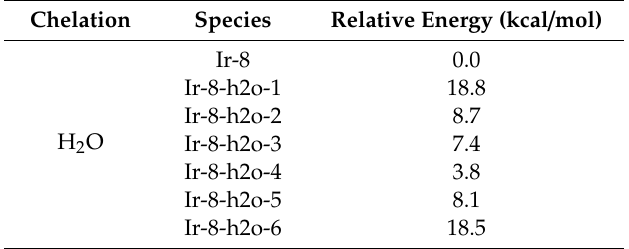
Table 3. The e ff ect of H 2 O, NH 3 and THF to the stabilization of complex I-8